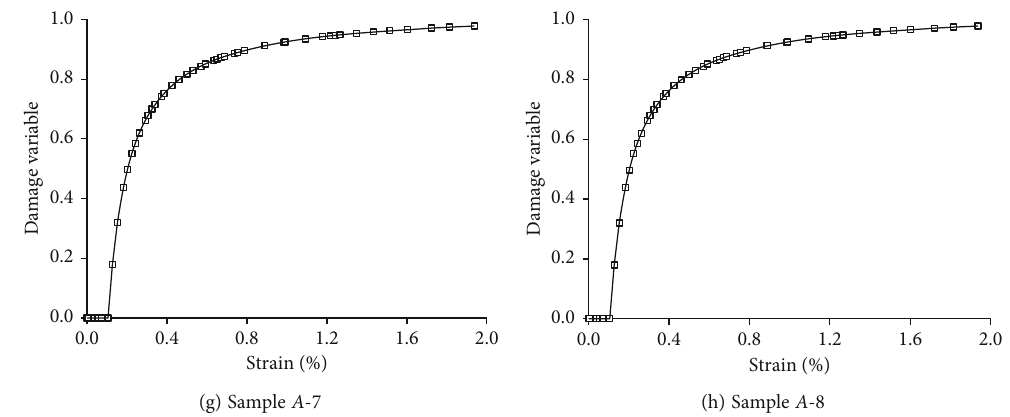
Figure 5: Damage variables based on axial